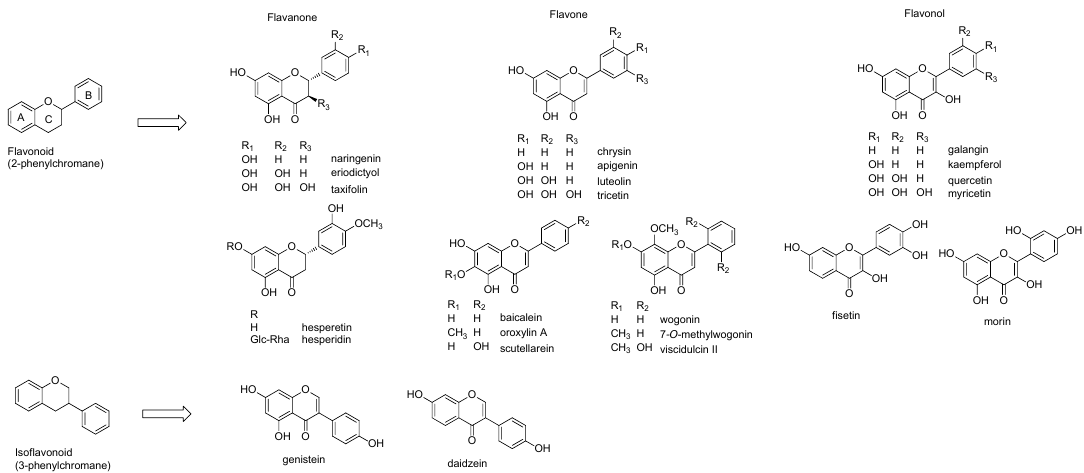
Figure 1. Structures of basic flavonoids and selected structures. Two main classes of flavonoids, Flavonoid (flavones, flavanones, and flavonols), and Isoflavonoid, are presented and additionally, modified flavonoids are frequently found in dietary and medicinal plants are